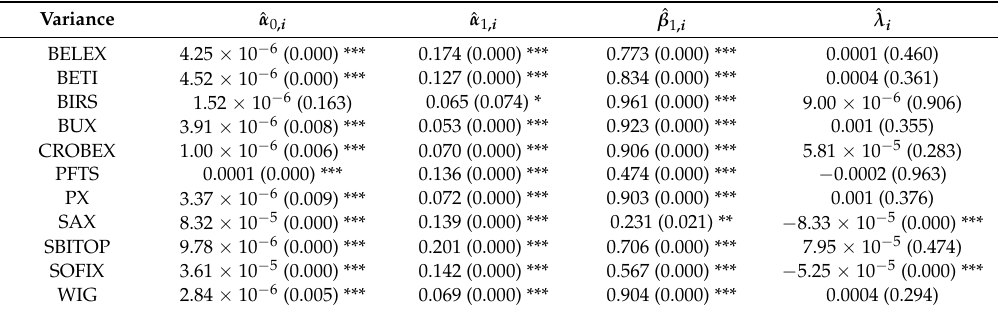
Table A4. GARCH estimation results, binary variable for three days after the